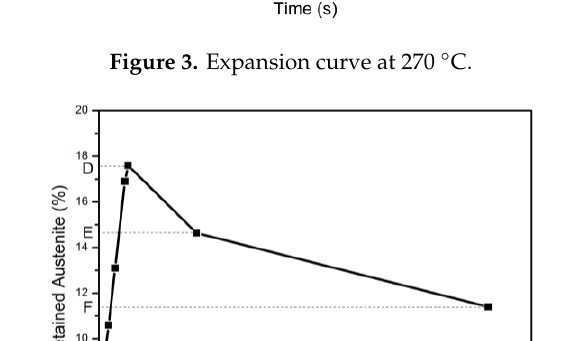
Figure 3. Expansion curve at 270 °C.